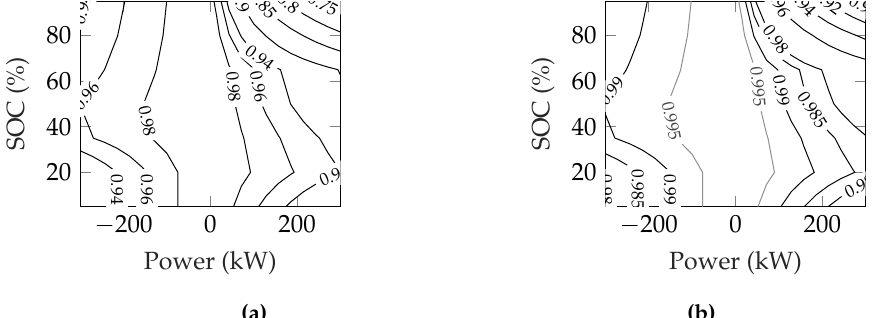
Figure 9. Battery efficiency of a 100 kWh ( a ), and a 400 kWh ( b ) battery respectively. Negative power indicates discharging.